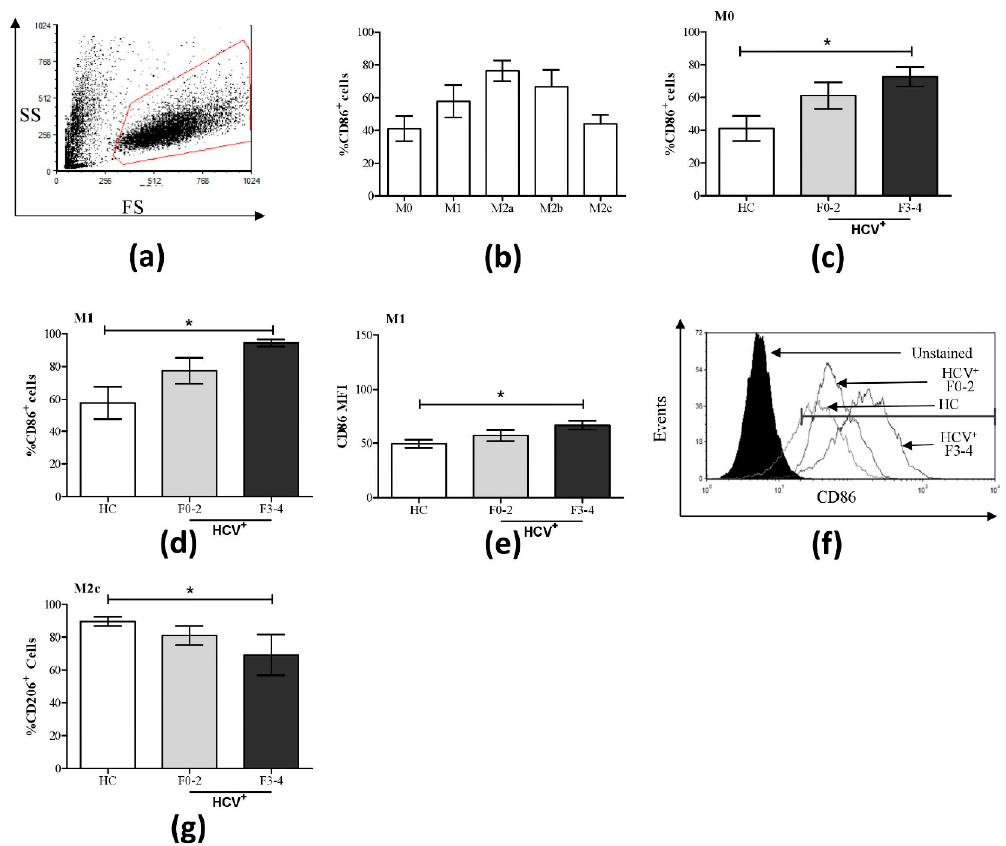
Figure 1. Increased percentage of CD86 + cells in M0 and M1 macrophage subsets and decreased CD206 expression in M2c cells in HCV infection. The expression of CD86 and CD206 was assessed on macrophage subsets from healthy controls (HC, n = 9) and HCV-infected individuals with minimal (F0-2, n = 9) or advanced liver fibrosis (F3-4, n = 4) by flow cytometry. ( a ) A representative dot plot of macrophage flow cytometry gating based on forward and side scatter is shown. ( b ) The proportion (%) of CD86 + cells across all macrophage subsets from healthy individuals is shown. Significant changes in % CD86 + cells in HCV + study groups are shown for ( c ) M0 and ( d ) M1 cells. ( e ) Included is the degree of CD86 expression (mean fluorescence intensity, MFI) in M1 cells, which is accompanied by ( f ) a representative histogram with overlapping data traces from an uninfected donor and HCV- infected individuals with minimal or advanced liver fibrosis. ( g ) Significant changes in the % CD206 + cells were also found in the M2c subset. Statistical significance was determined in healthy controls by one-way, paired Student’s t -tests, and significance among HCV-infected groups was determined by a one-way ANOVA ( p ≤ 0.05). Significant p -values are indicated with an asterisk “*”. 3.2. Altered Pro- and Anti-Inflammatory Cytokine Expression on Macrophage Subsets from HCV-Infected Patients While the expression of cell surface receptors can be somewhat variable in determining macrophage subset polarization in humans, the expression of cytokines can confer a better appreciation of functional polarization. To further determine if MDM subsets are further phenotypically and functionally altered in HCV infection, the cytokine production profiles of MDM subset cultures were determined. After the 48 h polarization of MDM, the polarizing stimuli were removed by aspirating culture supernatants and fresh medium was added for a further 24 h incubation, as described previously [29]. The concentration of TNF- α , IL-12, IFN- γ , and IL-10 in culture supernatants were quantified by immunobead assay. The secretion profiles of TNF- α , IL-12,